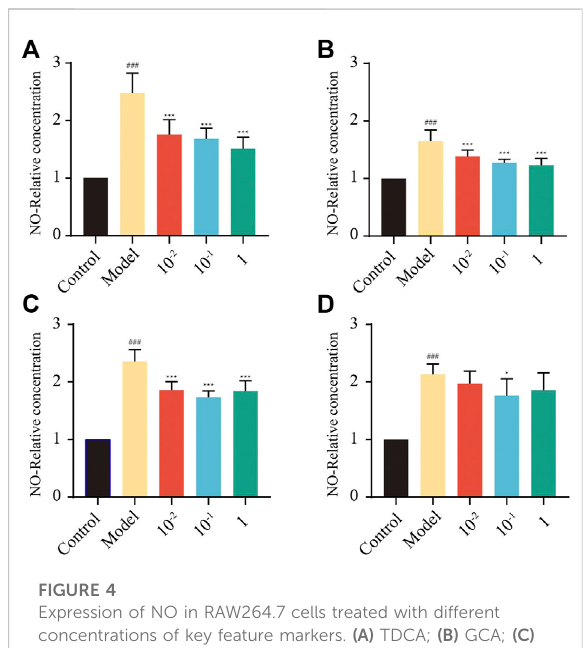
FIGURE 4 Expression of NO in RAW264.7 cells treated with different concentrations of key feature markers. (A) TDCA; (B) GCA; (C) GCDCA; (D) CA. ( ## p < 0.01: Model vs. Control; * p < 0.05, ** p < 0.01: Model vs.